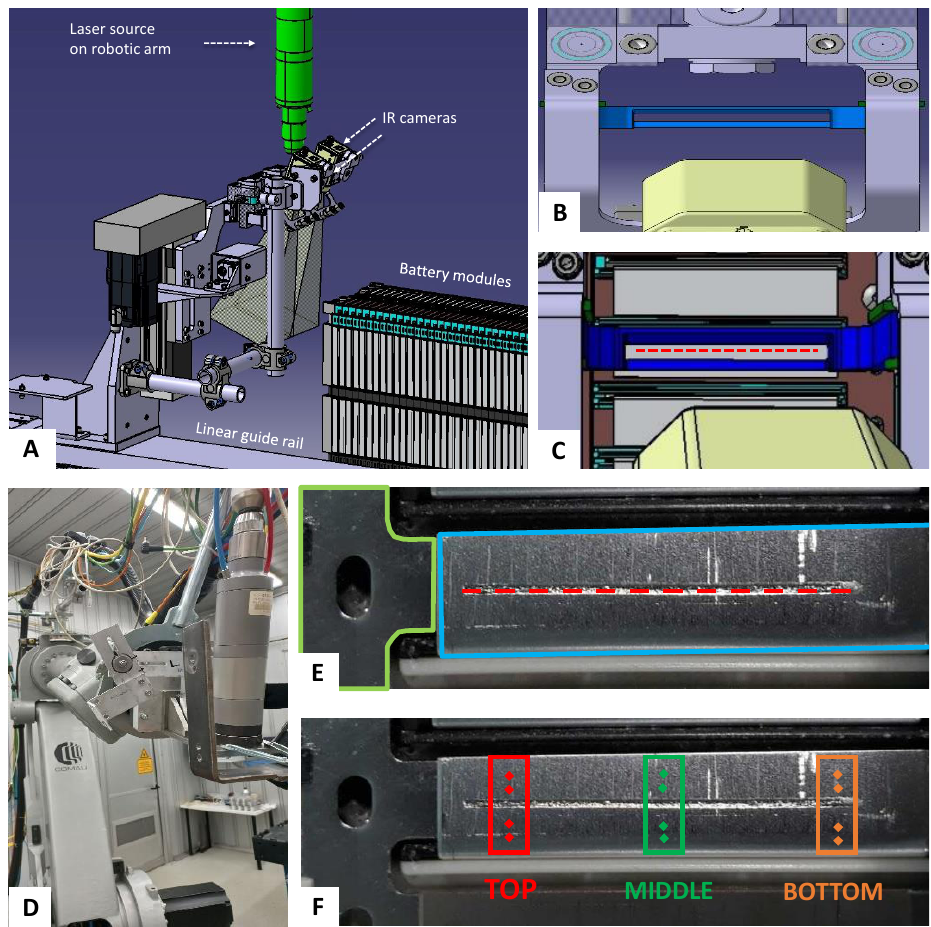
Figure 1. ( A ) Welding setup prior to start of welding process, showing the laser source (in green), mounted on an industrial 6-axes robot; two synchronized IR cameras that record heating and cooling transients; battery modules fixed to a linear guide rail that cyclically moves towards cameras, stopping once reaching the target position where tab and busbar are under the cameras field of view. ( B ) View of the setup from behind one of the two cameras before welding starts. The IR camera (in yellow) is mounted on a support framed with the clamping unit (in blue) with an orientation that enables the recording of the welding process, avoiding collision with the robotic arm. ( C ) View of a new configuration in which the linear guide rail has reached the target position under the camera. Once in this condition, the clamping unit (in blue) presses on the aluminum tab (electrode, in gray) in order to ensure a repeatable coupling with the copper busbar (in brown). Then, the robot can approach, and finally it welds the joint with a constant speed, following the laser path (dashed red line) whose length is 40 mm. The clamping unit is designed to allow both the welding process and the recording through the camera, as well as to ensure a repeatable gap between the layers. ( D ) The industrial 6-axes robot with the mounted laser head. ( E ) The result after the weld: the laser path (dashed red line), the electrode (blue), part of the busbar (green). ( F ) Graphic representation of the measuring instrument probes position during the three executions of the electrical resistance measurement, using the four-wire